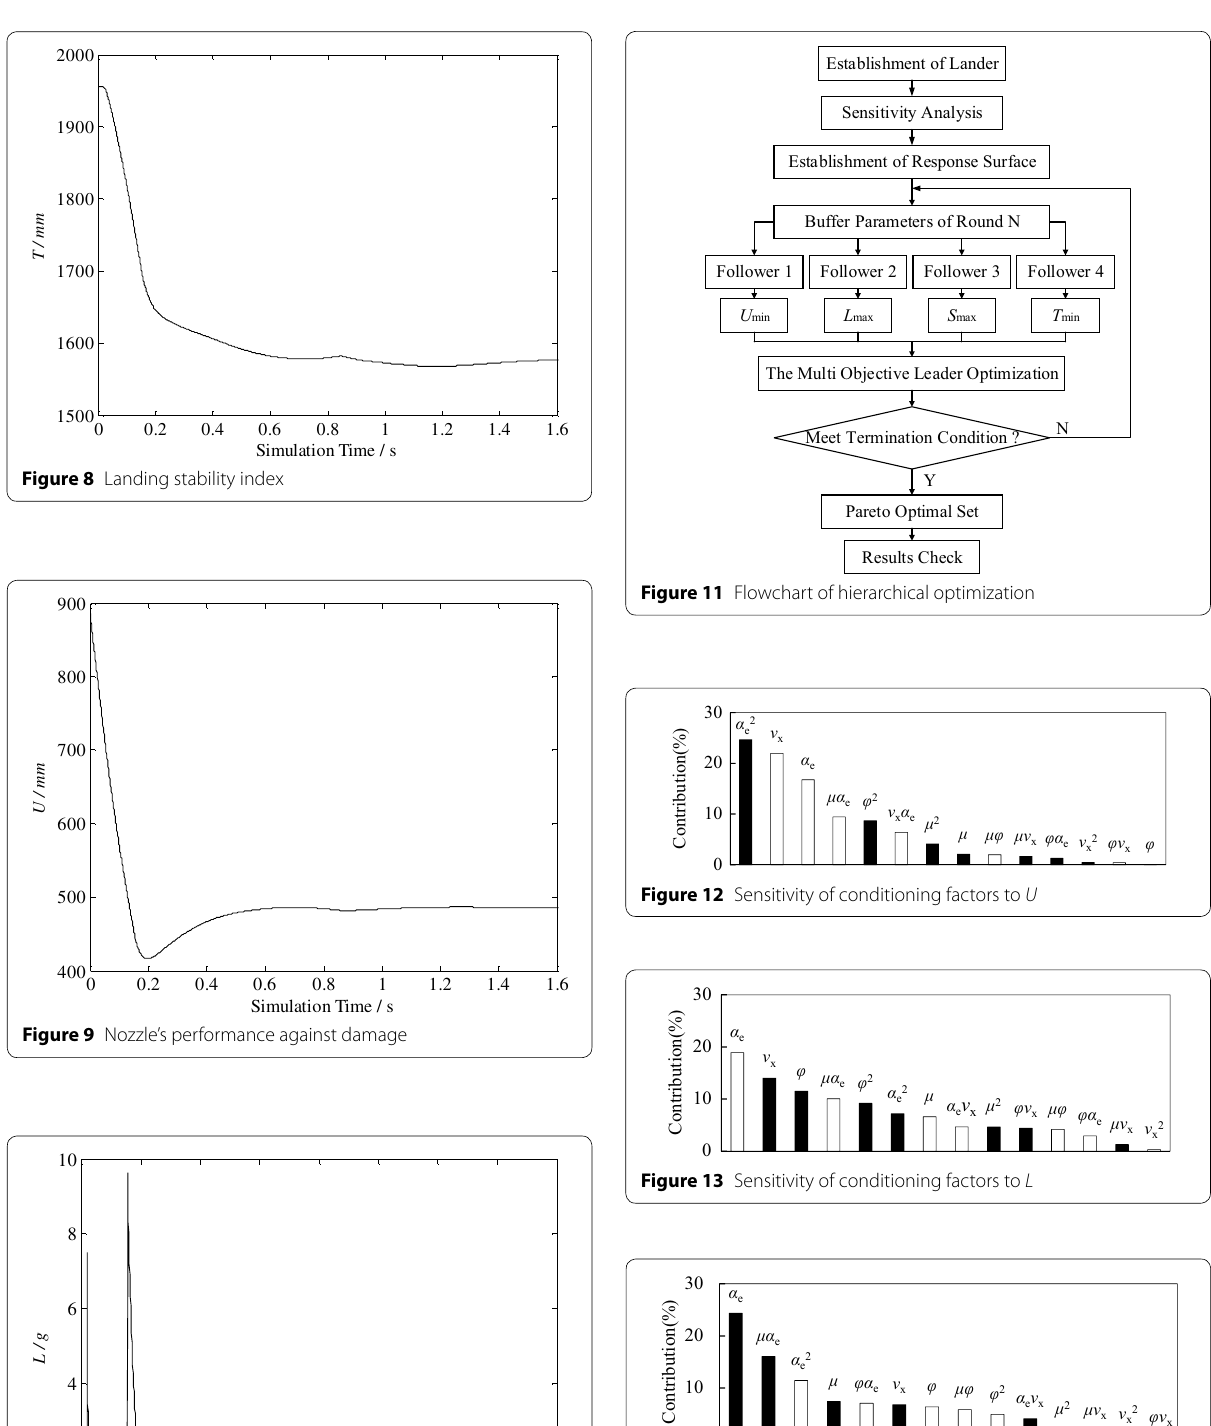
Figure 14 Sensitivity of conditioning factors to